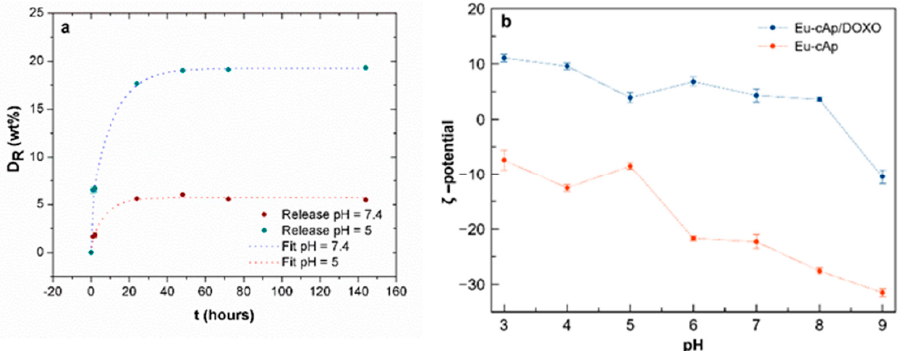
Figure 4. ( a ) kinetics of Doxo release from Eu:cit-cAp / Doxo at pH 7.4 and pH 5.0; ( b ) evolution of ζ –potential of Eu:cit-cAp nanocarriers and Eu:cit-cAp / Doxo at pHs from 3 to 9.